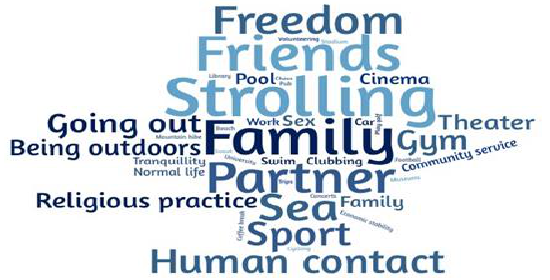
Figure 1. Word cloud representation of the main answers to the question: In a word, what do you miss more?